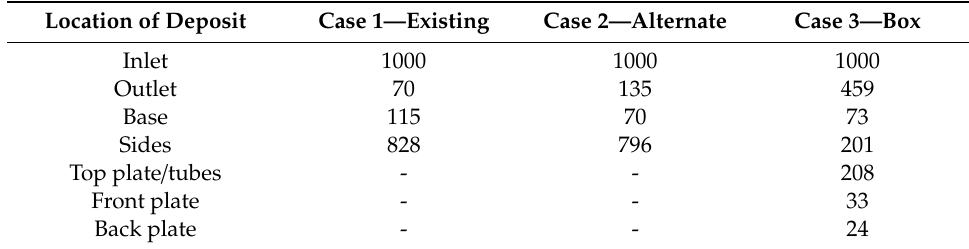
Table 2. Fates of particles predicted by CFD